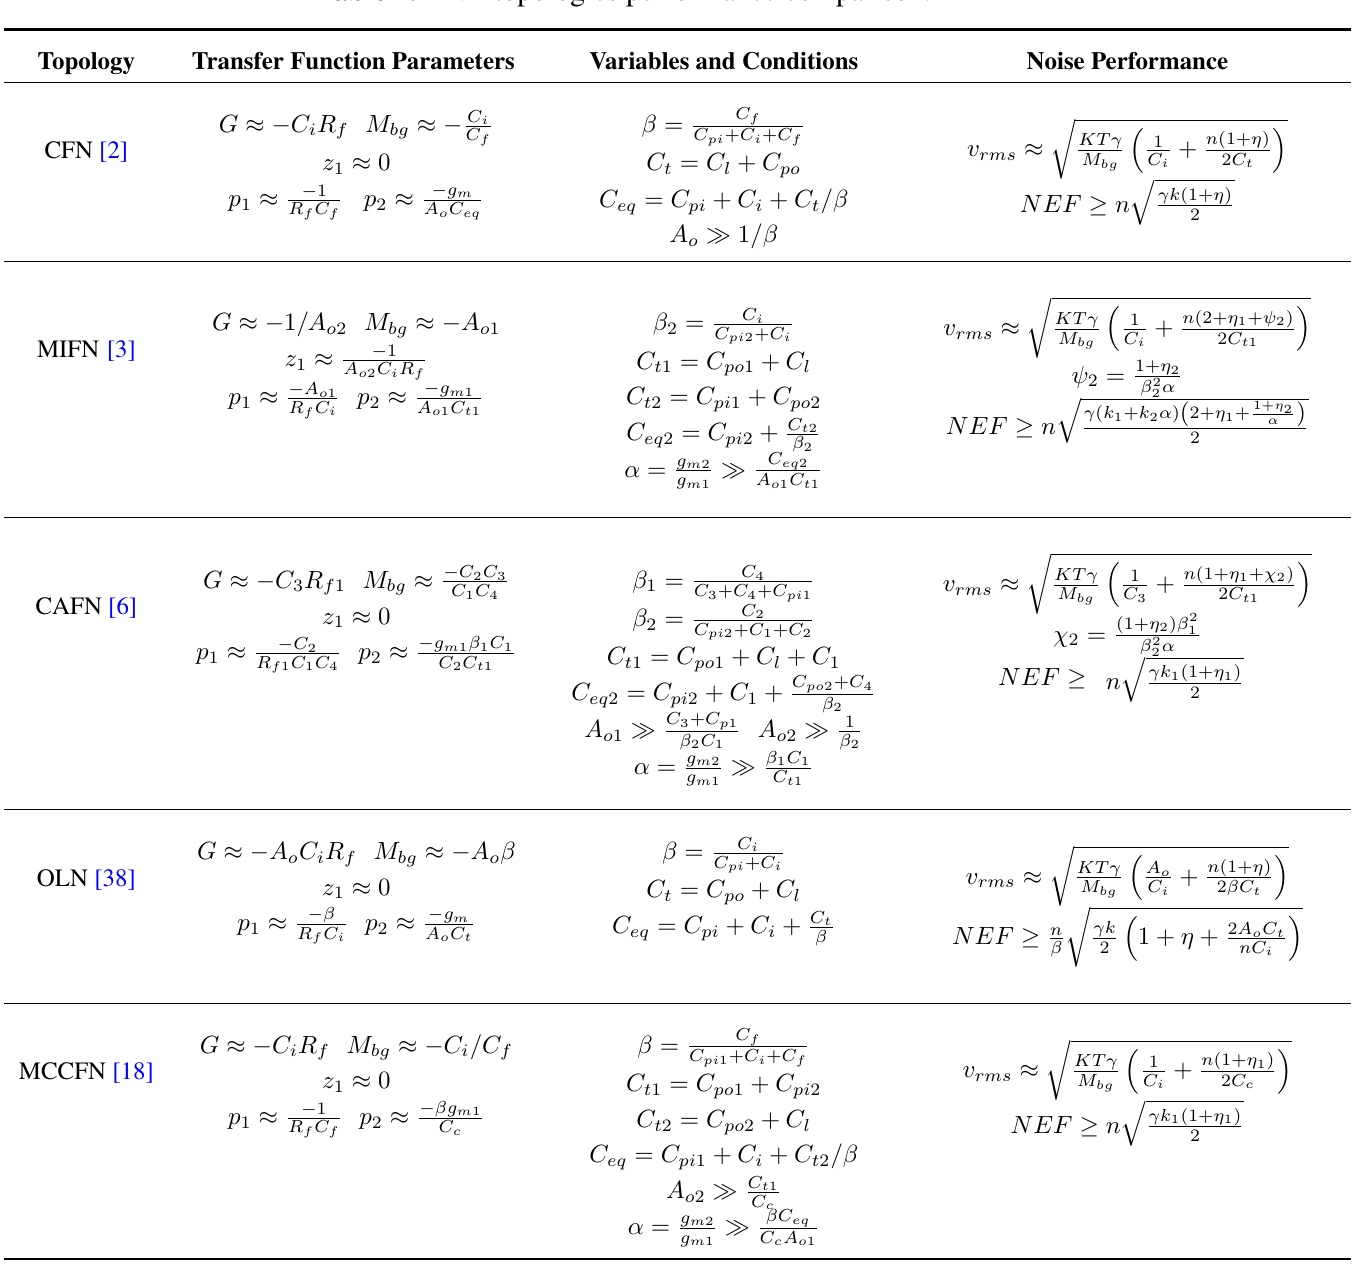
Table 1. LNA topologies performance